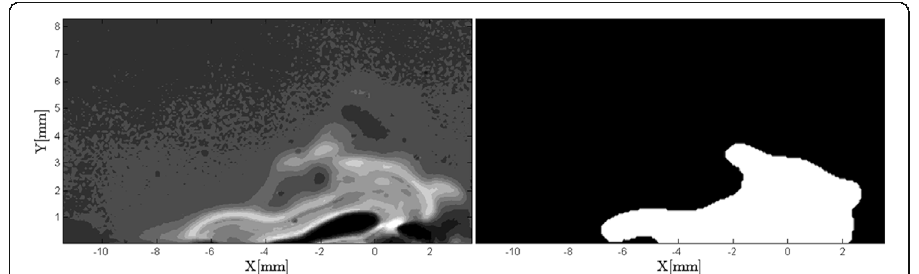
Fig. 6 Unprocessed schlieren frame of the discharge of a nanosecond-pulsed DBD (left) and the same frame in which the heated region produced by the discharge is estimated by means of an algorithm processing the light intensity (right) [64] © Deutsche Physikalische Gesellschaft. Reproduced by permission of IOP Publishing. CC